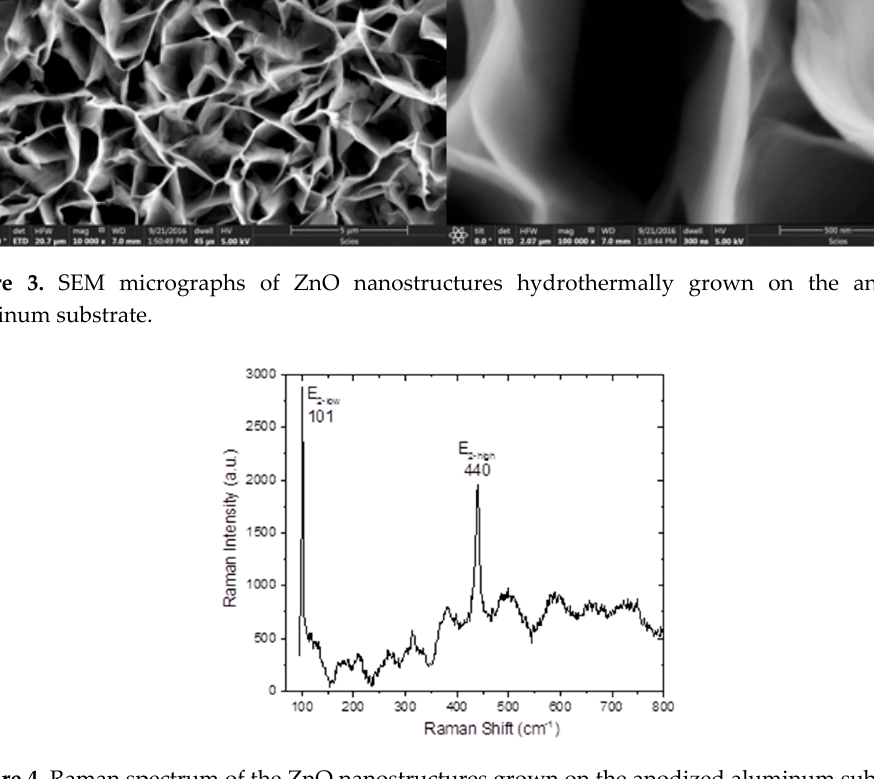
Figure 4. Raman spectrum of the ZnO nanostructures grown on the anodized aluminum substrate.